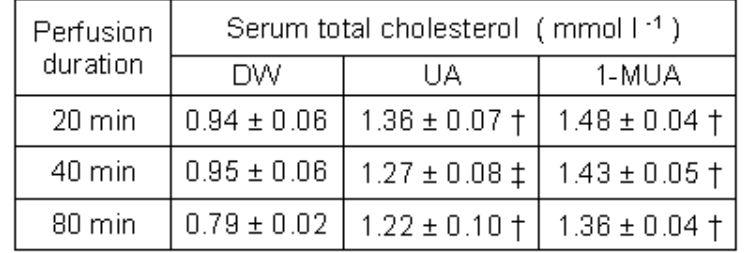
Serum Total Cholesterol Levels Following Perfusion of the Urinary Bladder with DW or UA or 1-MUA at 20, 40, and 80